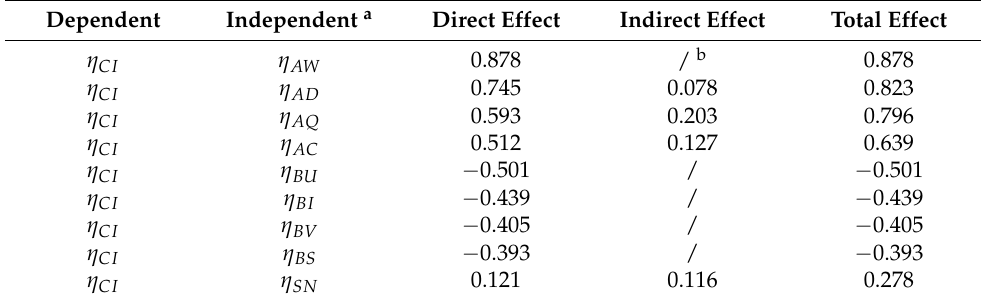
Table 4. Direct and indirect effects between latent attitudinal